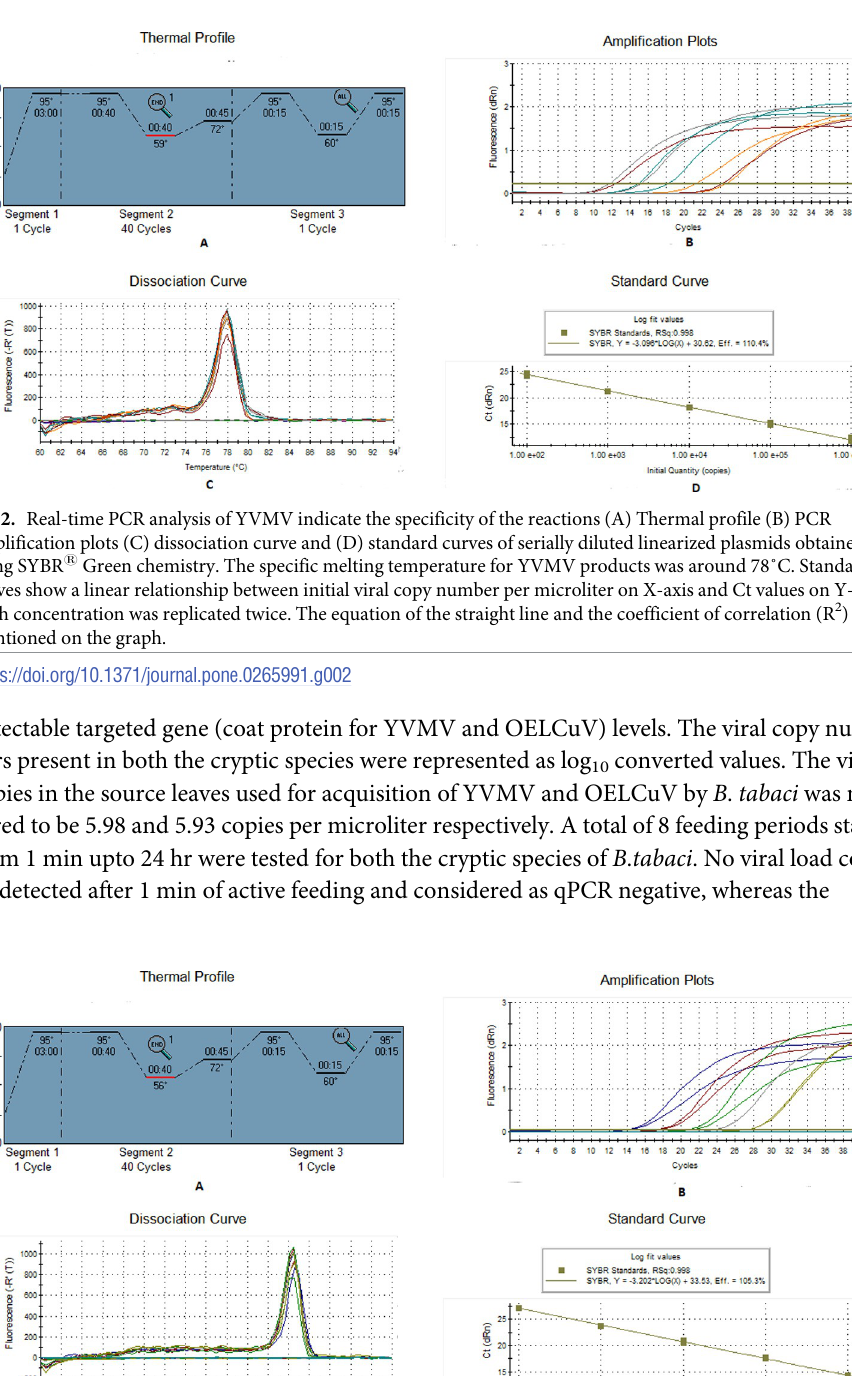
Fig 3. Real-time PCR analysis of OELCuV indicate the specificity of the reactions (A) Thermal profile (B) PCR amplification plots (C) dissociation curve and (D) standard curves of serially diluted linearized plasmids obtained using SYBR 1 Green chemistry. The specific melting temperature for YVMV products was around 84˚C. Standard curves show a linear relationship between initial viral copy number per microliter on X-axis and Ct values on Y-axis. Each concentration was replicated twice. The equation of the straight line and the coefficient of correlation (R 2 ) are mentioned on the graph.